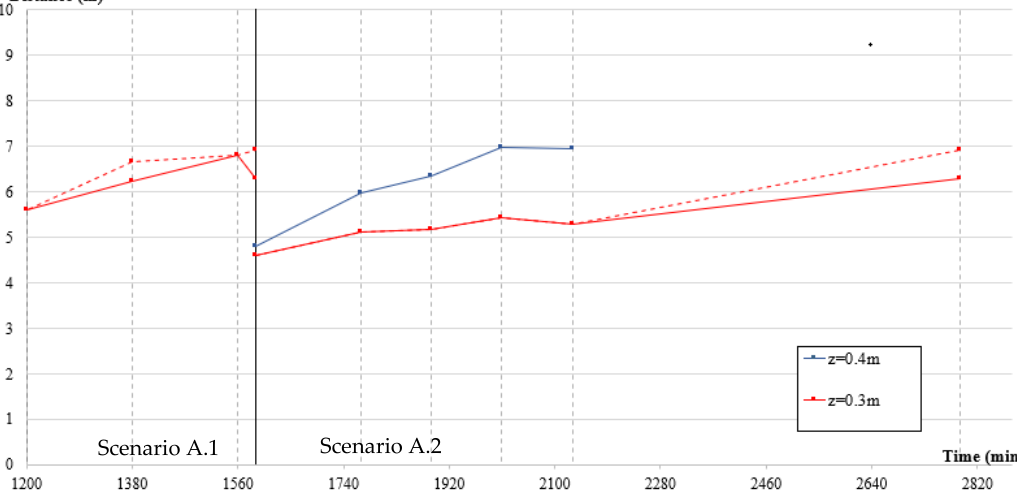
Figure 9. Timeline for profile P4 contour lines distance from the ADV. The vertical black line represents the transition between scenarios A.1 and A.2. The vertical black dashed lines represent the instants when the equipment was stopped.